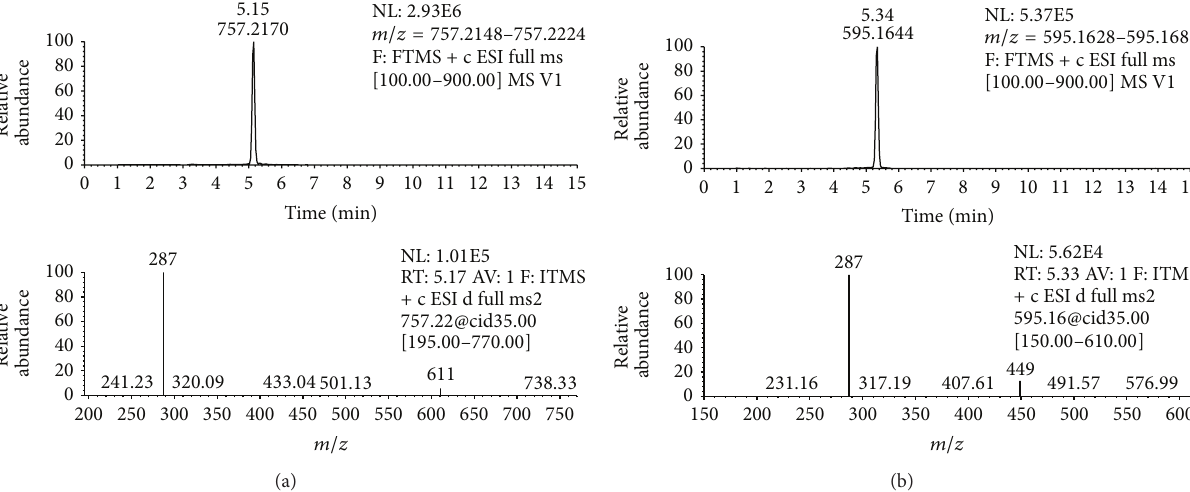
cyanidin-3-sophoroside, cyanidin-3-pentosylrutinoside, pel- argonidin-3-glucosylrutinoside, cyanidin-3-rutinoside, pe- onidin-3-rutinoside, and